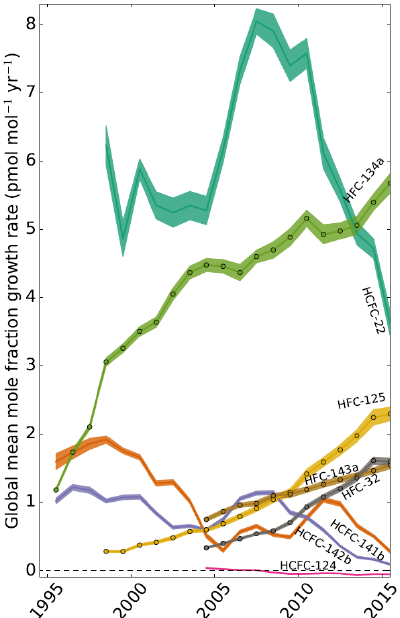
Figure 1. Illustrates the global mean mole fractions for the four HCFCs and the four HFCs discussed here (the model output was used for “gap-filling” purposes). Shading in the figure reflects the uncertainty on the mole fractions derived in the inversion and in- cludes a contribution from random and scale-related measurement errors and modelling uncertainties (further details are provided in Rigby et al., 2014). Note that for HCFC-124, HFC-143a and HFC- 32 we only use GC-MS-Medusa data for these calculations; for all others we use combined GC-MS-ADS and GC-MS-Medusa data.